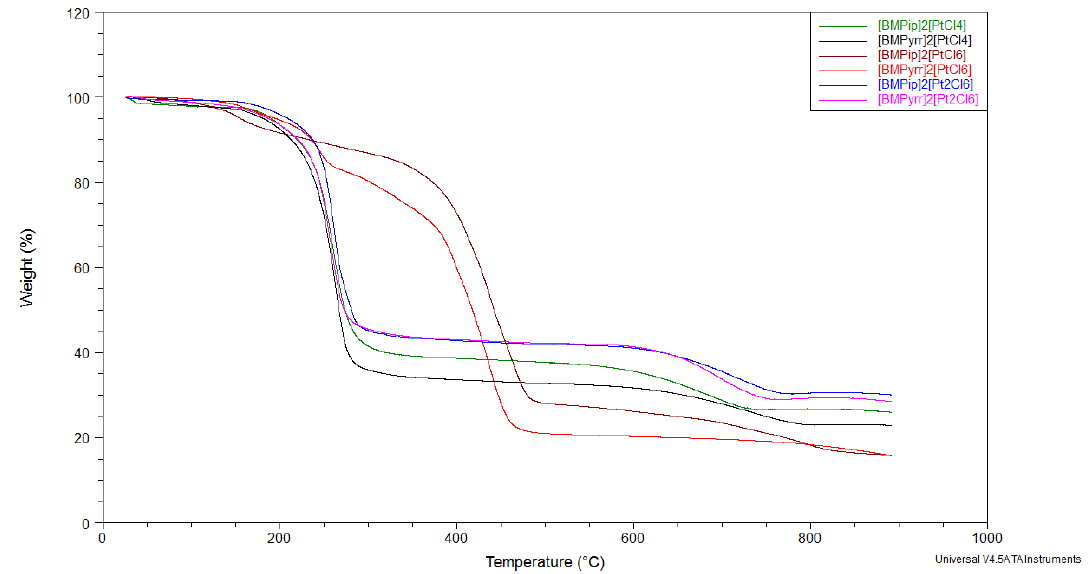
Figure 1. Thermogravimetric curves of chloroplatinate complexes.